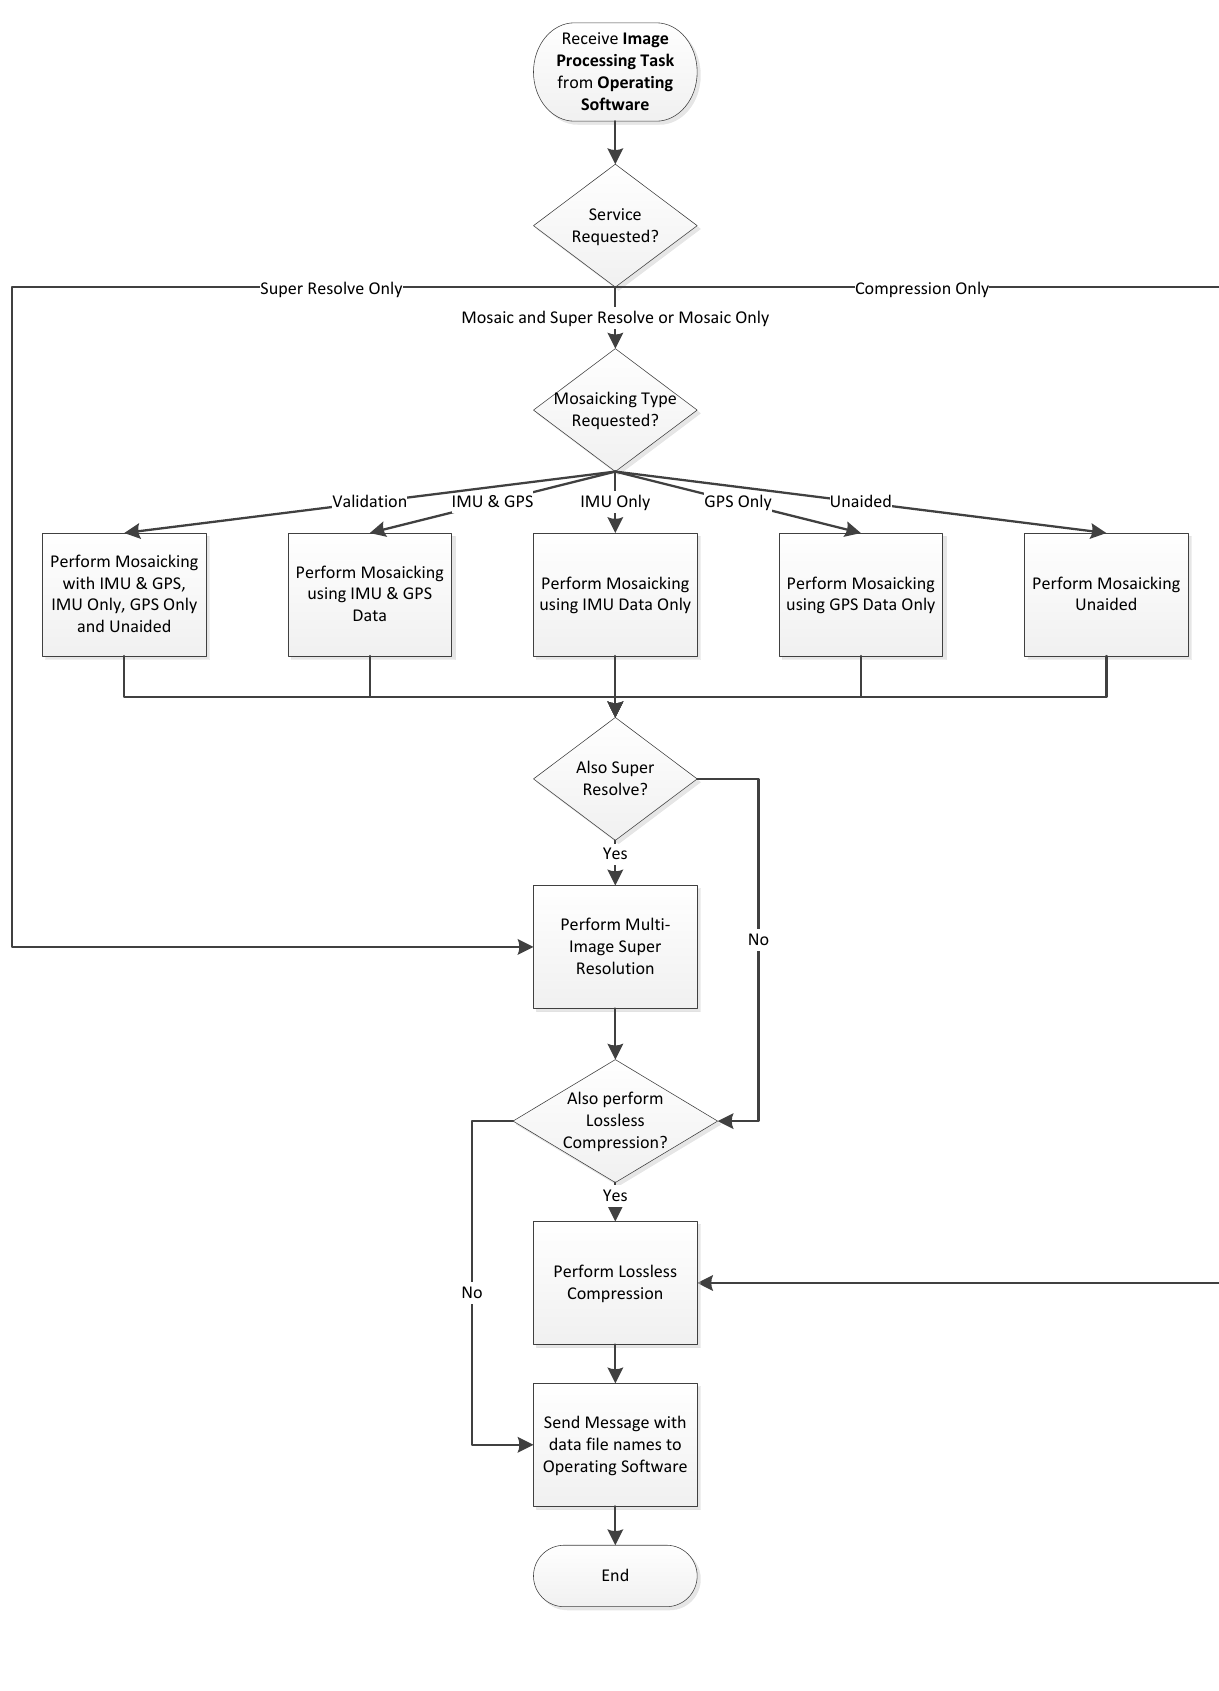
Figure 9. Payload Software Processing